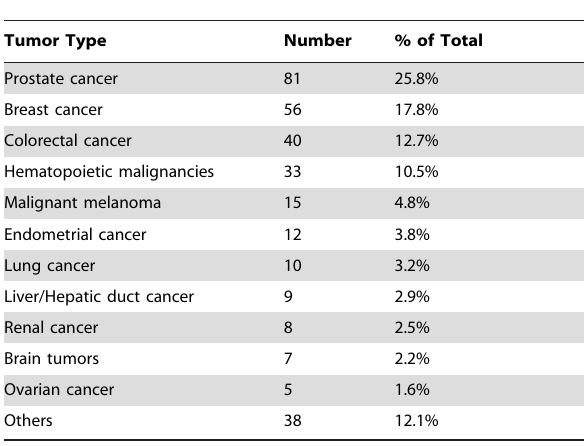
Figure 5. Blood RTL and prognosis in prediagnostic samples from prostate cancer patients. Shorter than median RTL $ 9 years before diagnosis was associated with decreased survival.